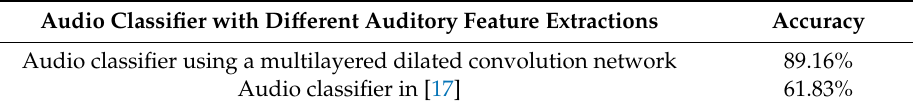
Table 2. Detection accuracy comparison based on auditory